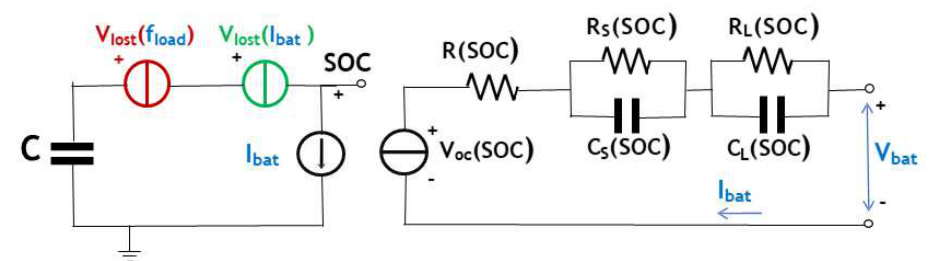
Figure 3. Adopted circuit-equivalent model for one single battery